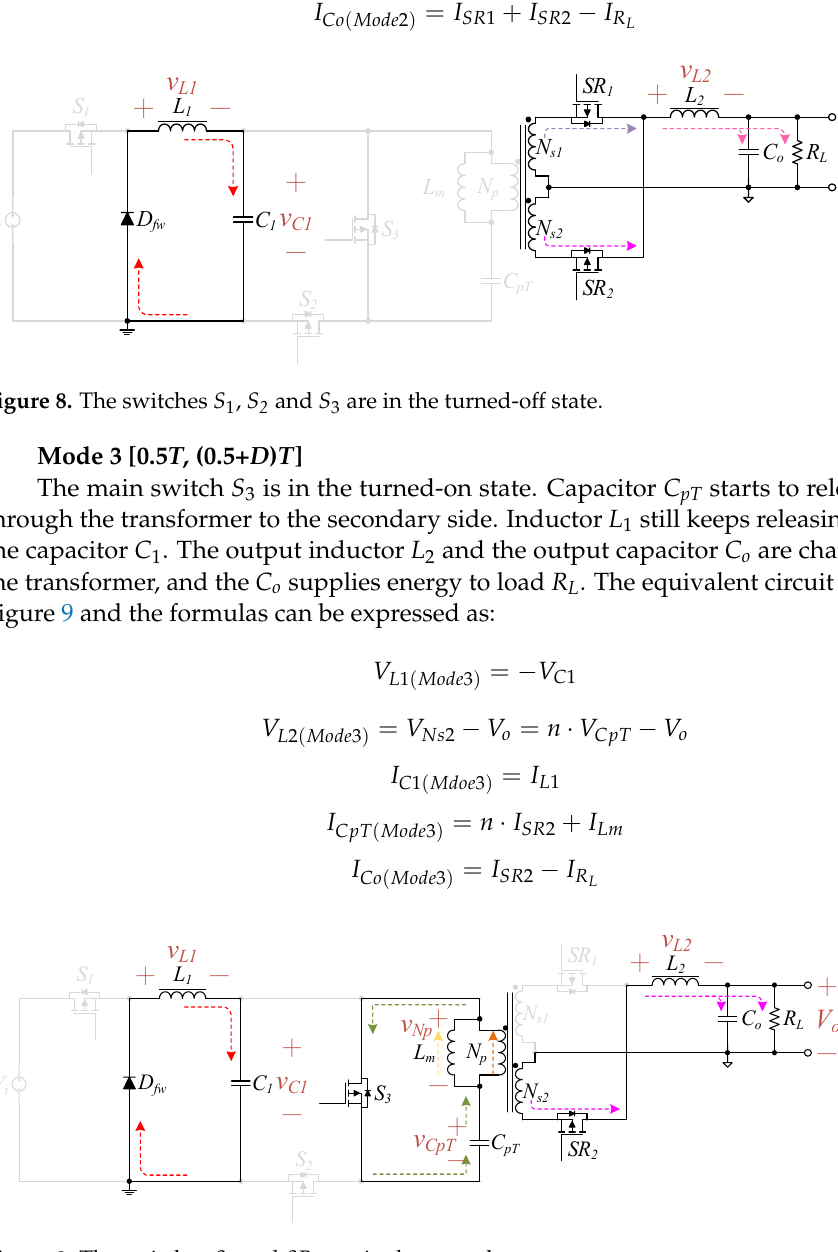
Figure 9. The switches S 3 and SR 2 are in the turned-on state. Mode 4 [(0.5+ D ) T , T